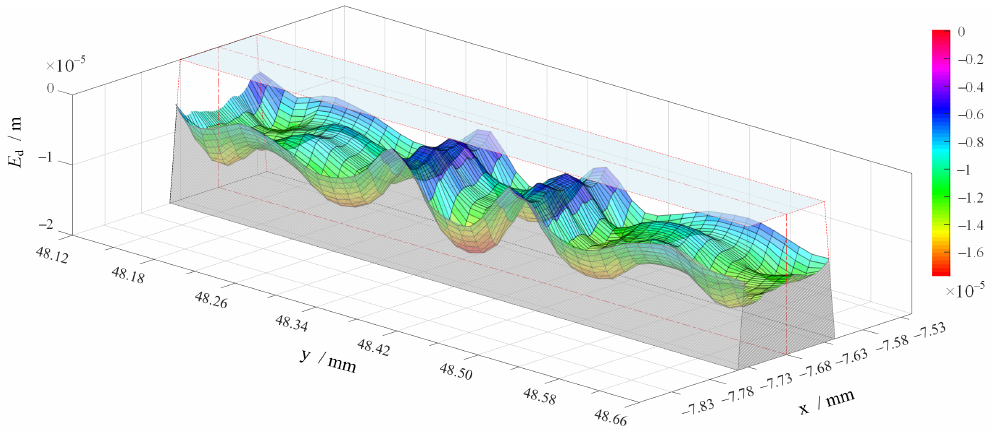
Figure 20. Erosion depth distribution after 1000h for oil of NAS 7.